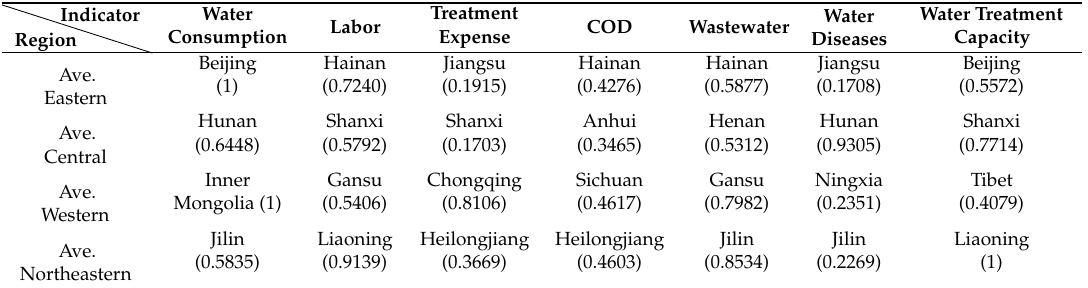
Table 5. The typical value of indicator